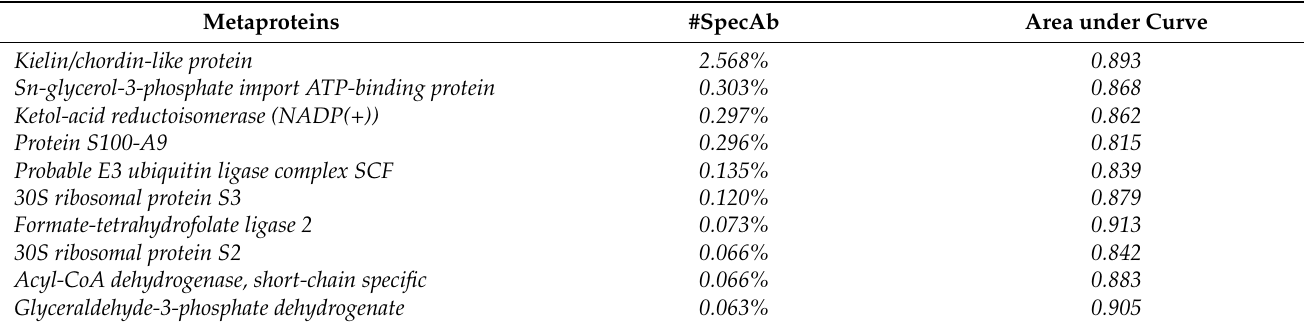
Table 1. Potential biomarker metaproteins between controls and diseased patients. We analyzed the ROC plot analysis for the most abundant ten metaproteins and summarized the area under the curve to evaluate metaprotein